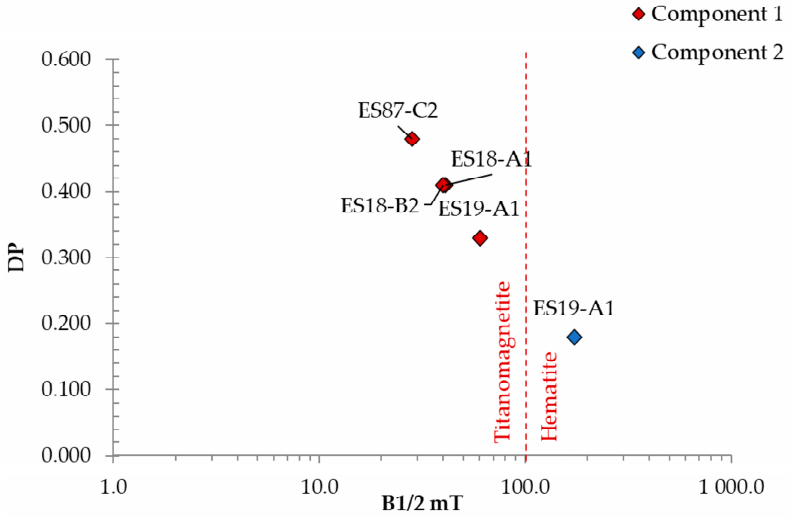
Figure 9. DP versus coercivity (B1/2).